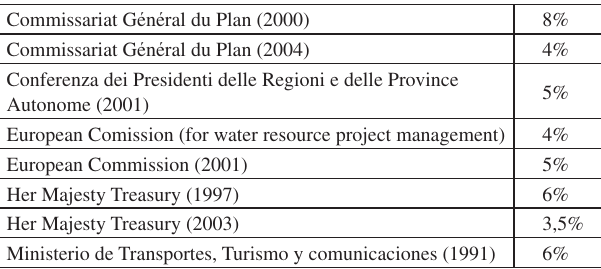
Table 1. Different estimations of time-preference value